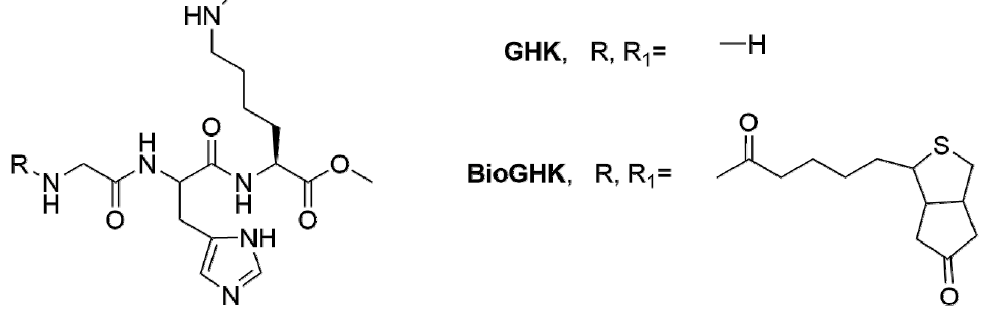
Figure 2. Structure of the matrikine tripeptide GHK and its biotinylated derivative BioGHK [62,72].